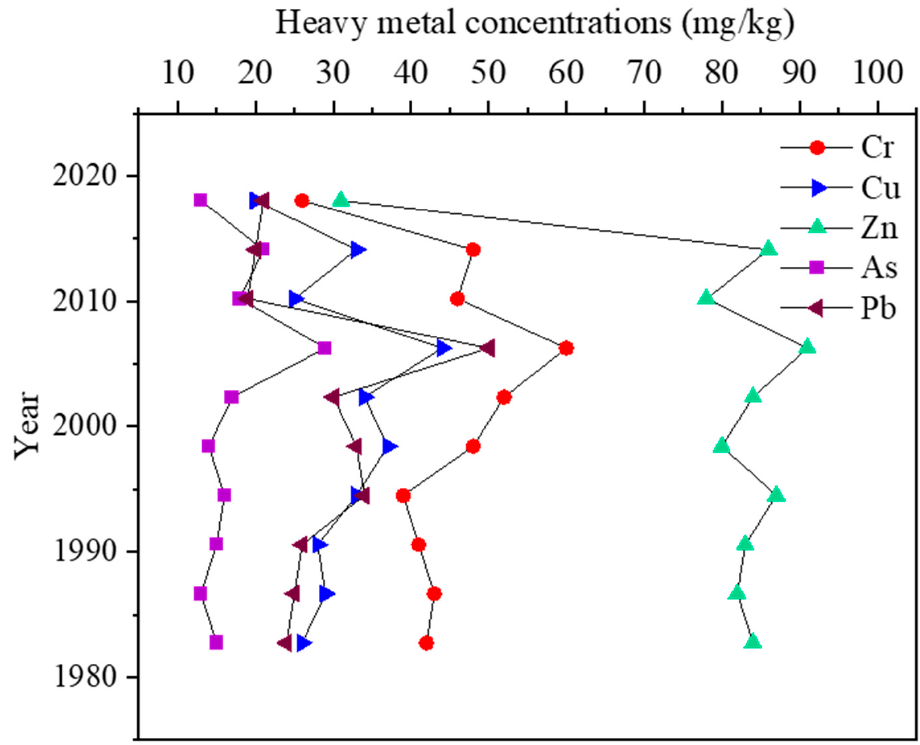
Figure 8. Temporal distribution profiles of heavy metals in the core sediments of Hulun Lake.